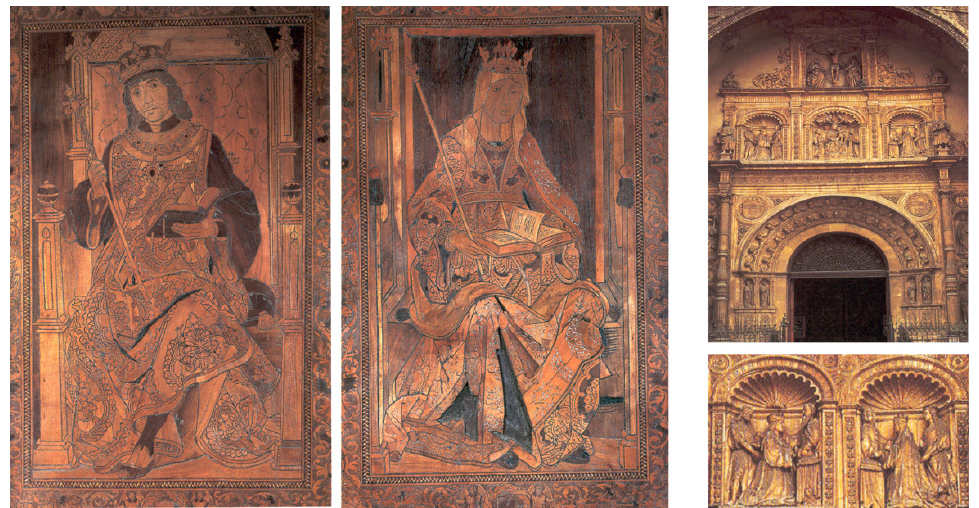
Figure 4. The Catholic Monarchs in the Plasencia cathedral stalls. 1497–1503. Published by [35] vol. II, p. 138; Santa Engracia monastery. 1514–1516. General view and detail of the Reyes Católicos. Published by [8], p. 239.